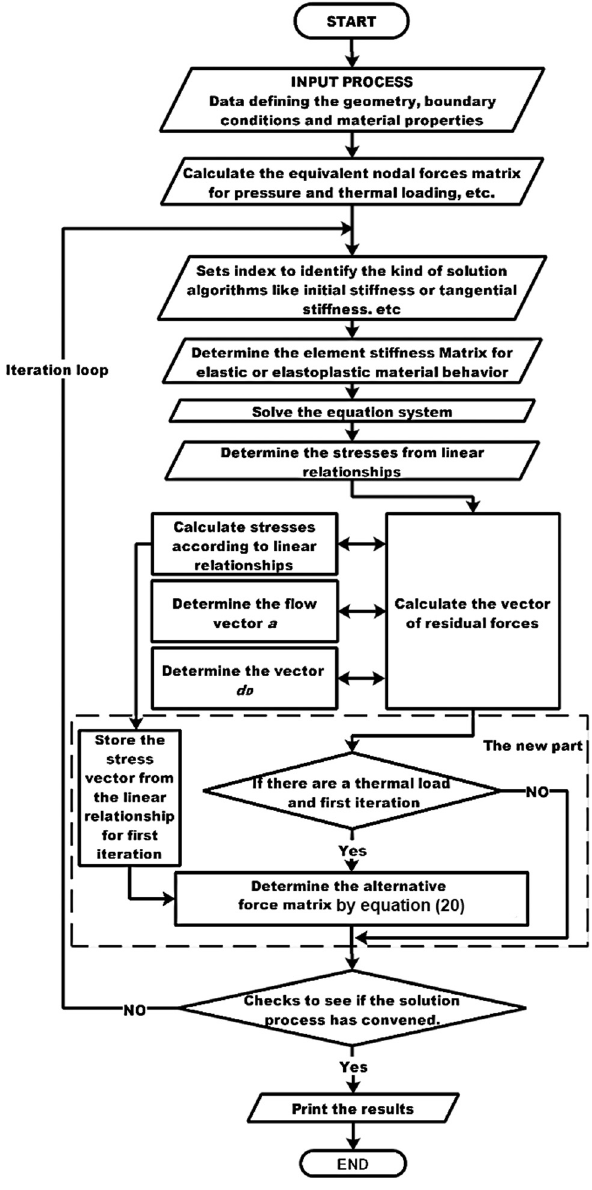
Figure 1: Program structure for elastic – plastic